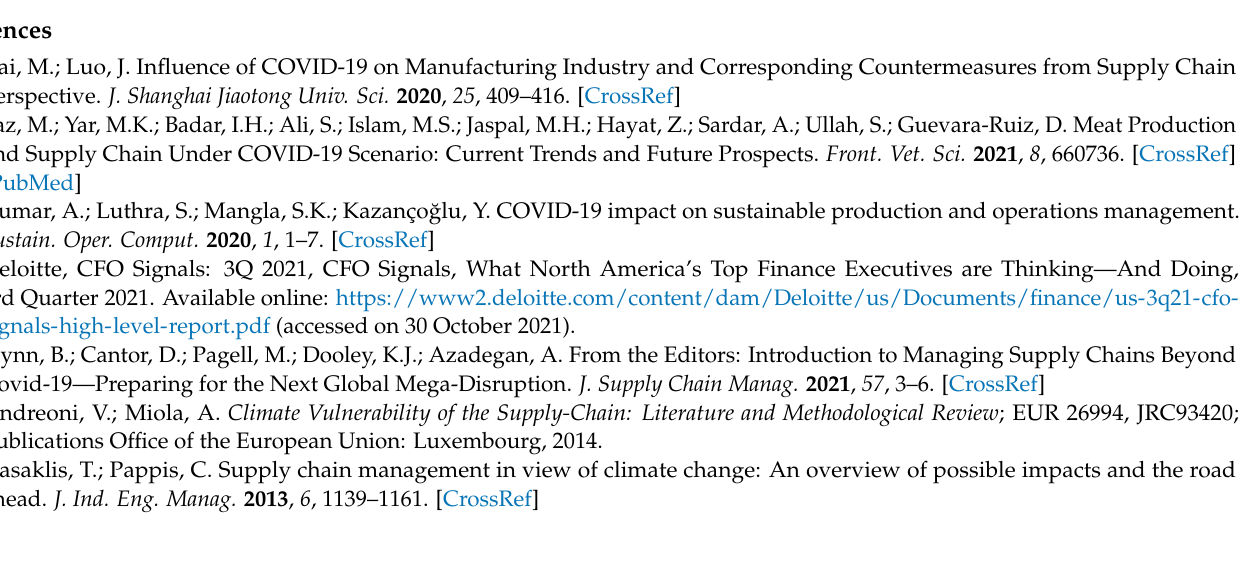
stron 8872 machine. Figure S2: 3D-printed part (cubic) during compressive strength testing on Instron 8801 machine. Figure S3: 3D-printed parts for tensile creep testing, from PLA. Figure S4: 3D-printed parts for tensile creep testing, fromPETG. Figure S5: 3D-printed parts for practical compressive creep test, from PLA (blue) and PETG (transparent, white). Table S1: Measured dimensions of 3D-printed parts from control group and group exposed to